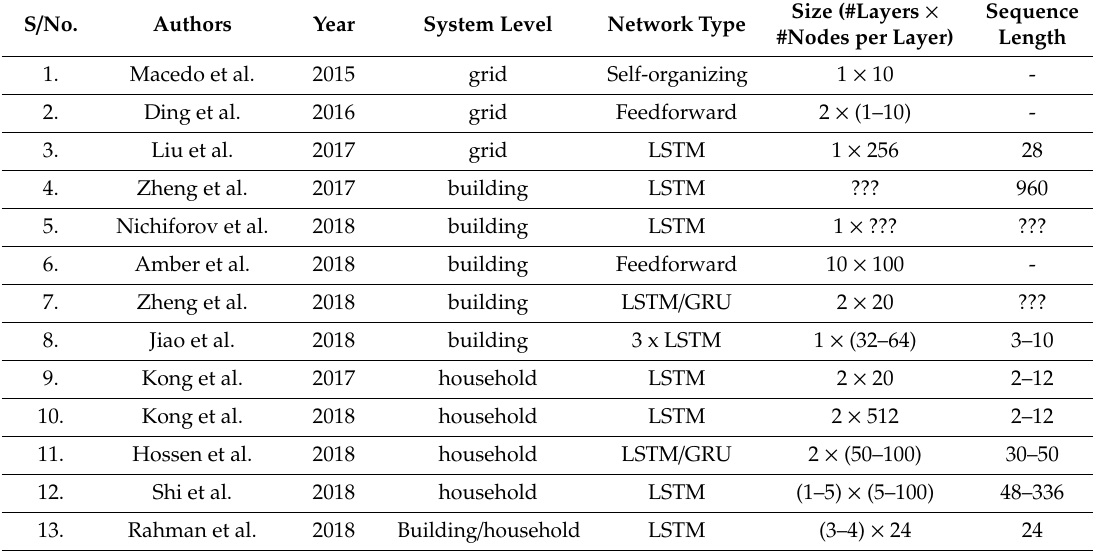
Table 1. Neural networks in energy load forecasting (??? = information not provided in paper). S /